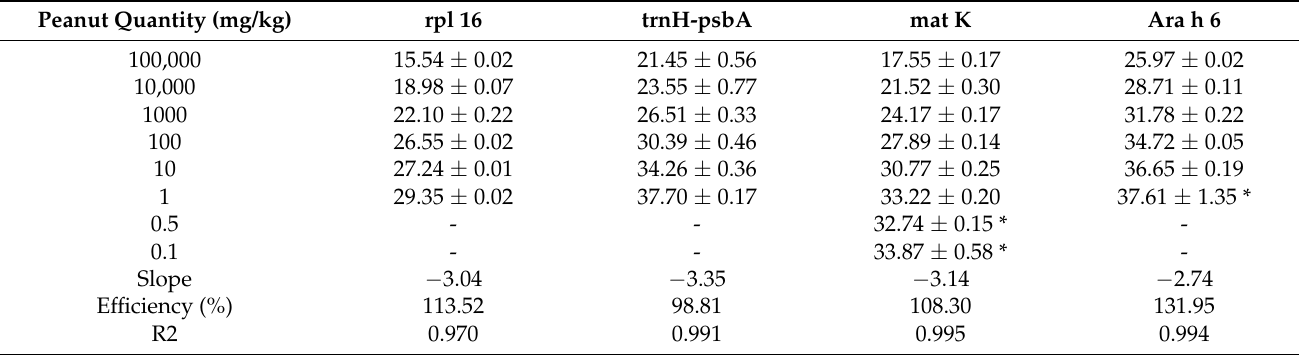
Table 2. Comparative data of calibration curves from binary mixtures of peanut in wheat, analyzed by real-time PCR using specific primers and probe for the four selected targets. Obtained Ct mean and SD for each spiked level is shown, as well as calibration curves’ parameters (slope, coefficient correlation, and efficiency of the reaction). All DNA samples were isolated by protocol 1.